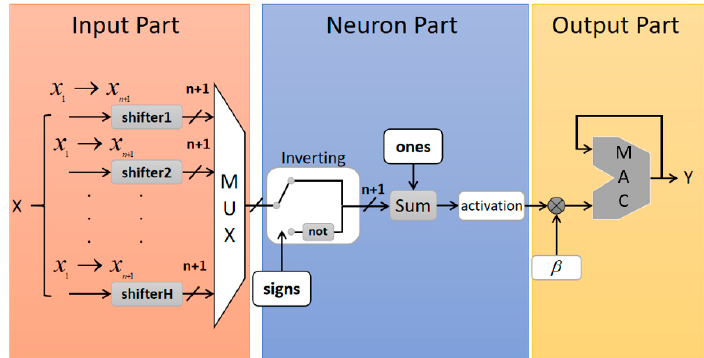
Figure 1. The architecture of FPGA-based SCN.